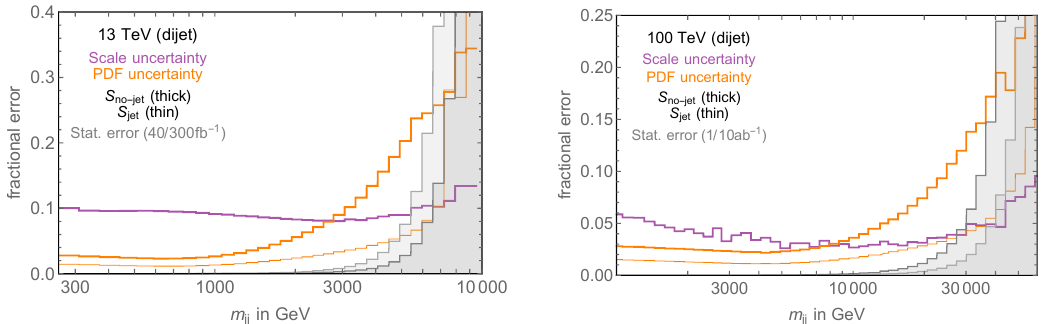
Figure 4 . Scale and PDF uncertainties for the central rapidity bin of the 13 TeV (left) and 100 TeV (right) dijet analyses. Similar results hold for for the inclusive jet p T analyses identifying p T (cid:24) m jj = 2. We also show the statistical uncertainty for two values of the integrated luminosity. place powerful constraints on modi(cid:12)cations of the QCD sector, such as those represented by eq. (1.5). The constraint on the Z parameter is at the level of 5 (cid:2) 10 (cid:0) 4 level, corresponding p to a mass scale M (cid:17) m = Z (cid:25) 3 : 5 W